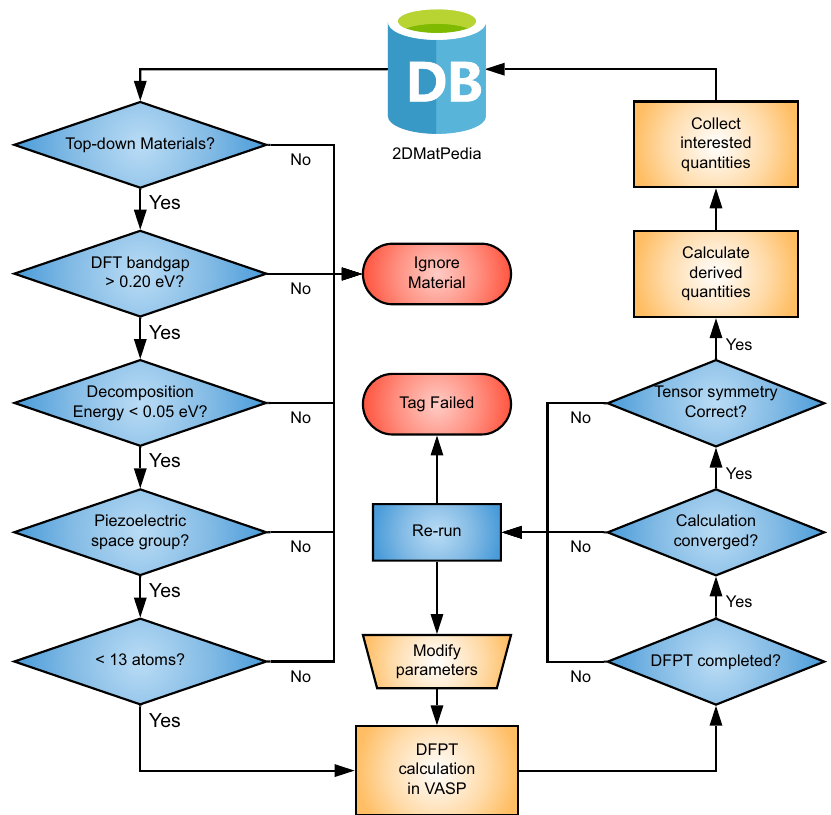
Fig. 1 Work fl ow of the high-throughput calculation to screen for piezoelectric 2D materials. We have chosen a criteria of at least 0.20 eV for the DFT band gap (large enough for operation at fi nite temperatures) and a decomposition energy 21 of < 0.05 eV to ensure thermodynamic